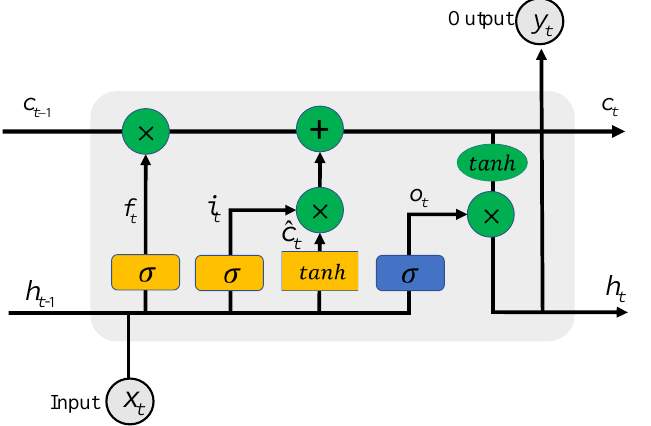
Figure 1. Schematic diagram of an LSTM cell at time step t [23]. Note that the output y t equals to the hidden state output h t